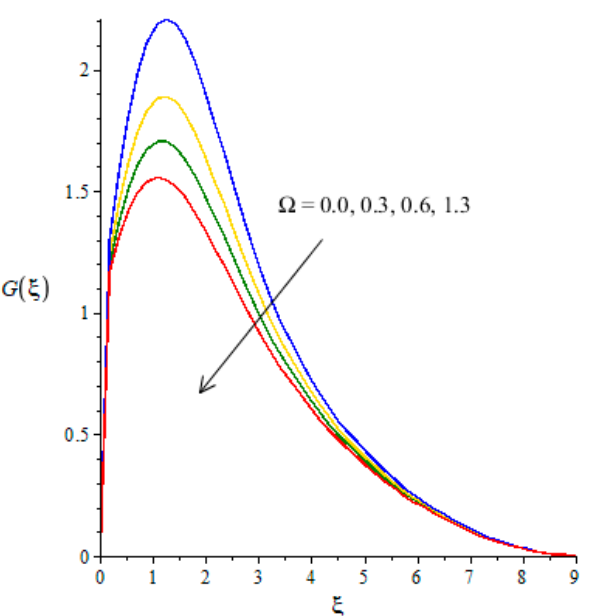
Figure 12. Variation role of −𝐺(𝜉) versus Ω when 𝑚 = 0.21, 𝑊𝑒 = 7, 𝑀 (cid:2870) = 0.4, 𝛽 (cid:3032) = 0.52, 𝛽 (cid:3036) = 0.3, 𝜖 = 0.01, 𝐹 (cid:3045) = 2.0, 𝑃𝑟 = 204, 𝐸𝑐 = 0.34,𝜑 (cid:2870) = 0.0075, 𝜑 (cid:2869) = 0.002,𝜑 (cid:2871) =